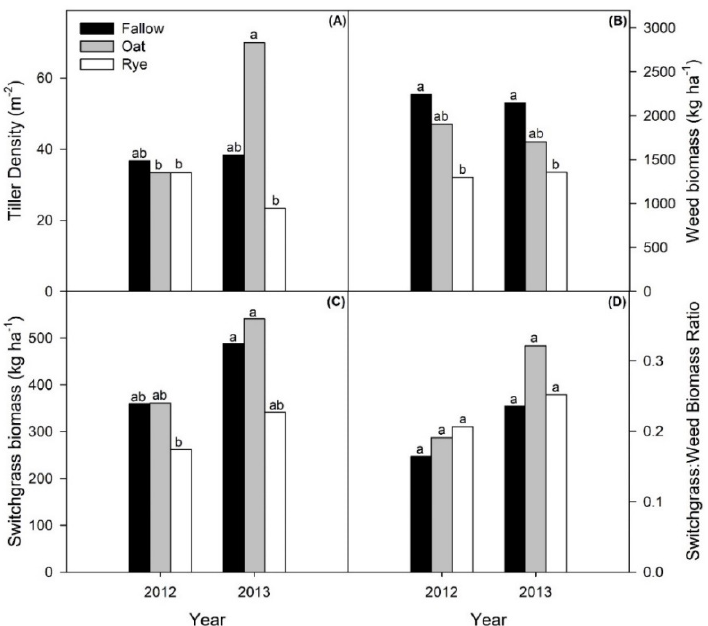
Figure 3. Comparison of switchgrass tiller density ( A ), weed biomass ( B ), switchgrass biomass ( C ) and switchgrass/weed biomass ratio ( D ) in the 2012 and 2013 growing seasons for the Shawnee switchgrass variety (Experiment 2). Different letters at the tops of the columns represent significant differences ( p < 0.05) between the